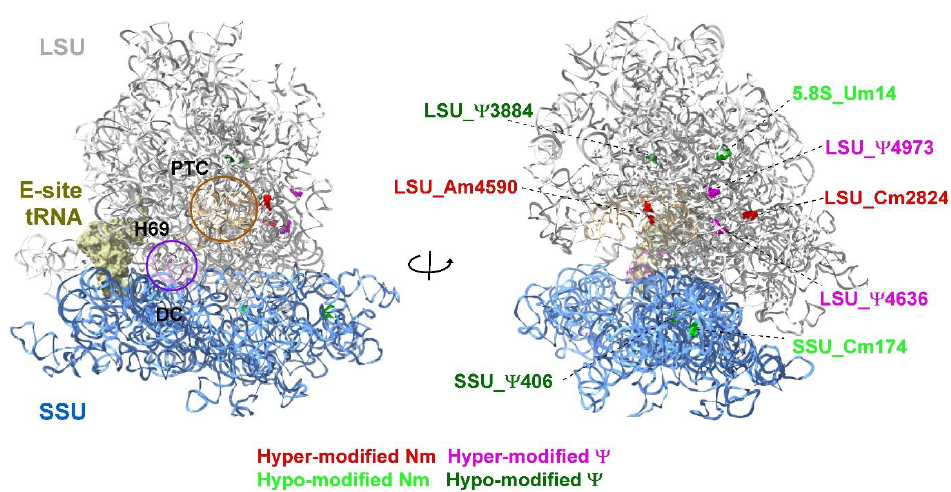
Figure 9. Localization of Ψ and Nm residues altered in KSHV-infected iSLK cells undergoing lytic reactivation. Uninfected SLK cells and BAC16-infected iSLK cells were treated with Dox and n-Butyrate for 48 h. The data are derived from HydraPsiSseq and RiboMeth-seq analysis. The location of peptidyl transferase center (PTC), E site tRNA, decoding center (DC) and helix H69 are shown. The large subunit (LSU) and small subunit (SSU) are colored in grey and blue, respectively. The 3D representation of human ribosome is based on the published CryoEM structure (PDB 6EK0) [98]. Figures were generated using UCSF Chimera-X software (https://www.rbvi.ucsf.edu/chimerax, accessed on 16 July 2022).